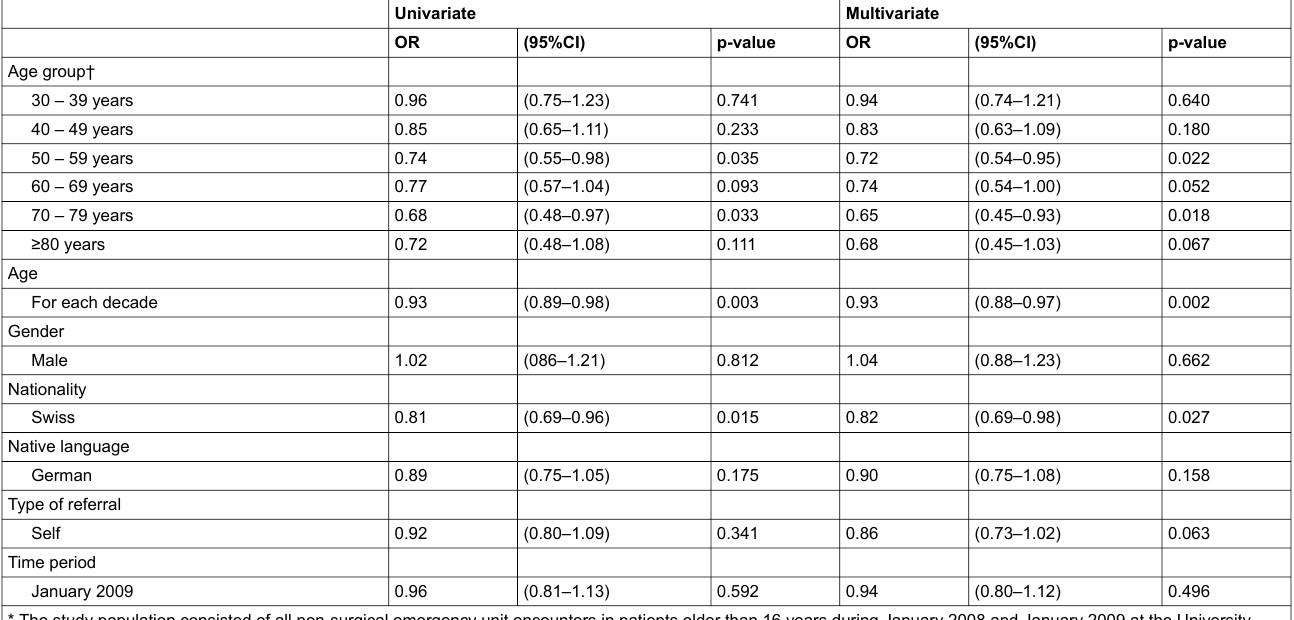
Table 2: Univariate and multivariate analyses of determinants of “non-urgent” encounters (N = 783) in a medical emergency unit population* (N = 2,623). Univariate